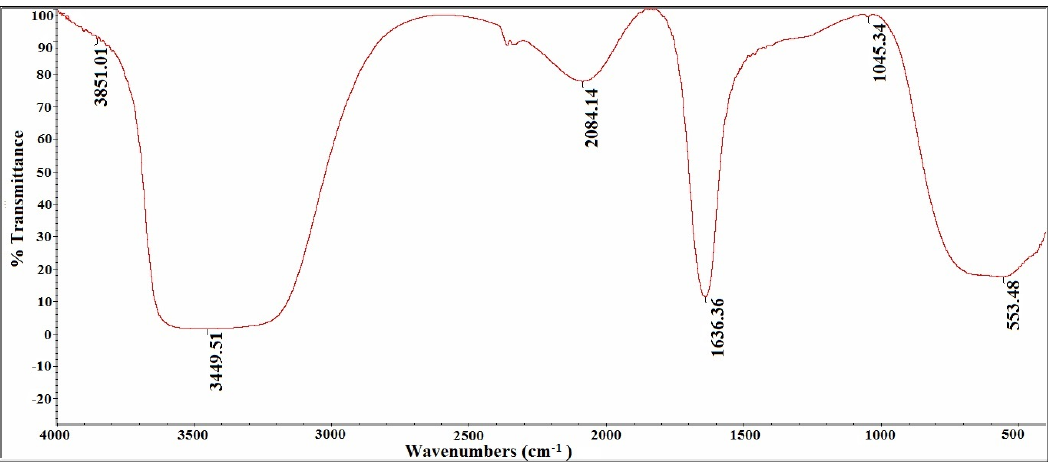
Figure 6. FTIR spectrum of the biosynthesized TiO 2 NPs .